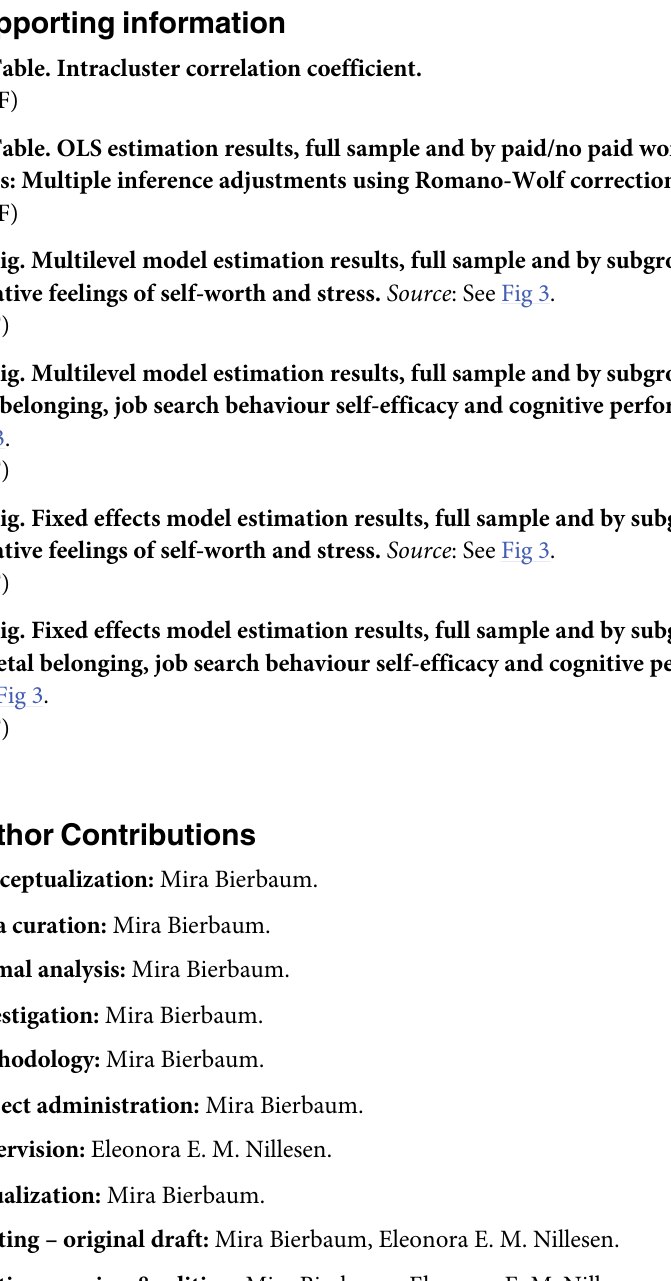
S1 Table. Intracluster correlation coefficient. S2 Table. OLS estimation results, full sample and by paid/no paid work in previous two years: Multiple inference adjustments using Romano-Wolf correction. S1 Fig. Multilevel model estimation results, full sample and by subgroups: Positive and negative feelings of self-worth and stress. Source : See Fig 3. S2 Fig. Multilevel model estimation results, full sample and by subgroups: Feelings of soci- etal belonging, job search behaviour self-efficacy and cognitive performance. Source : See